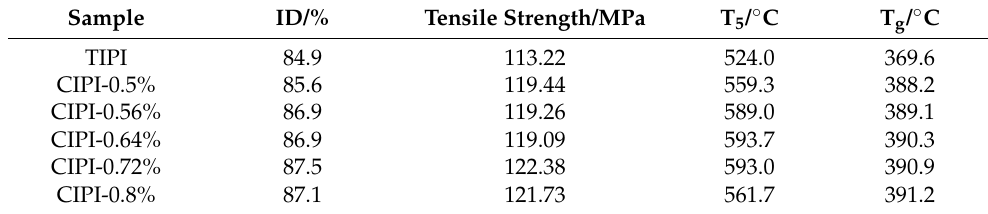
Figure 4 . Mechanical and thermal properties of TIPI and CIPI-w films: ( a ) stress–strain curves; ( b ) the relationship between tensile strength and ID; ( c ) TG and DTG; ( d ) DSC. Table 1. ID, mechanical and thermal performances of TIPI and CIPI-w films.